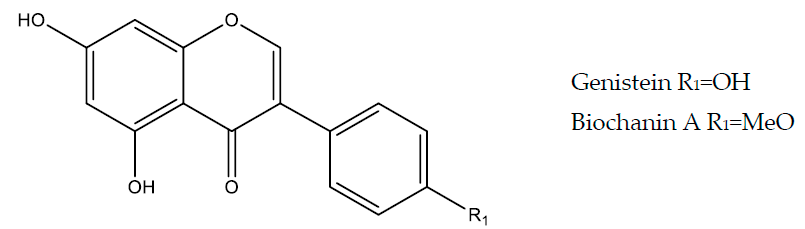
Figure 6. Isoflavonoids with gastroprotective and/or anti-ulcer activity.